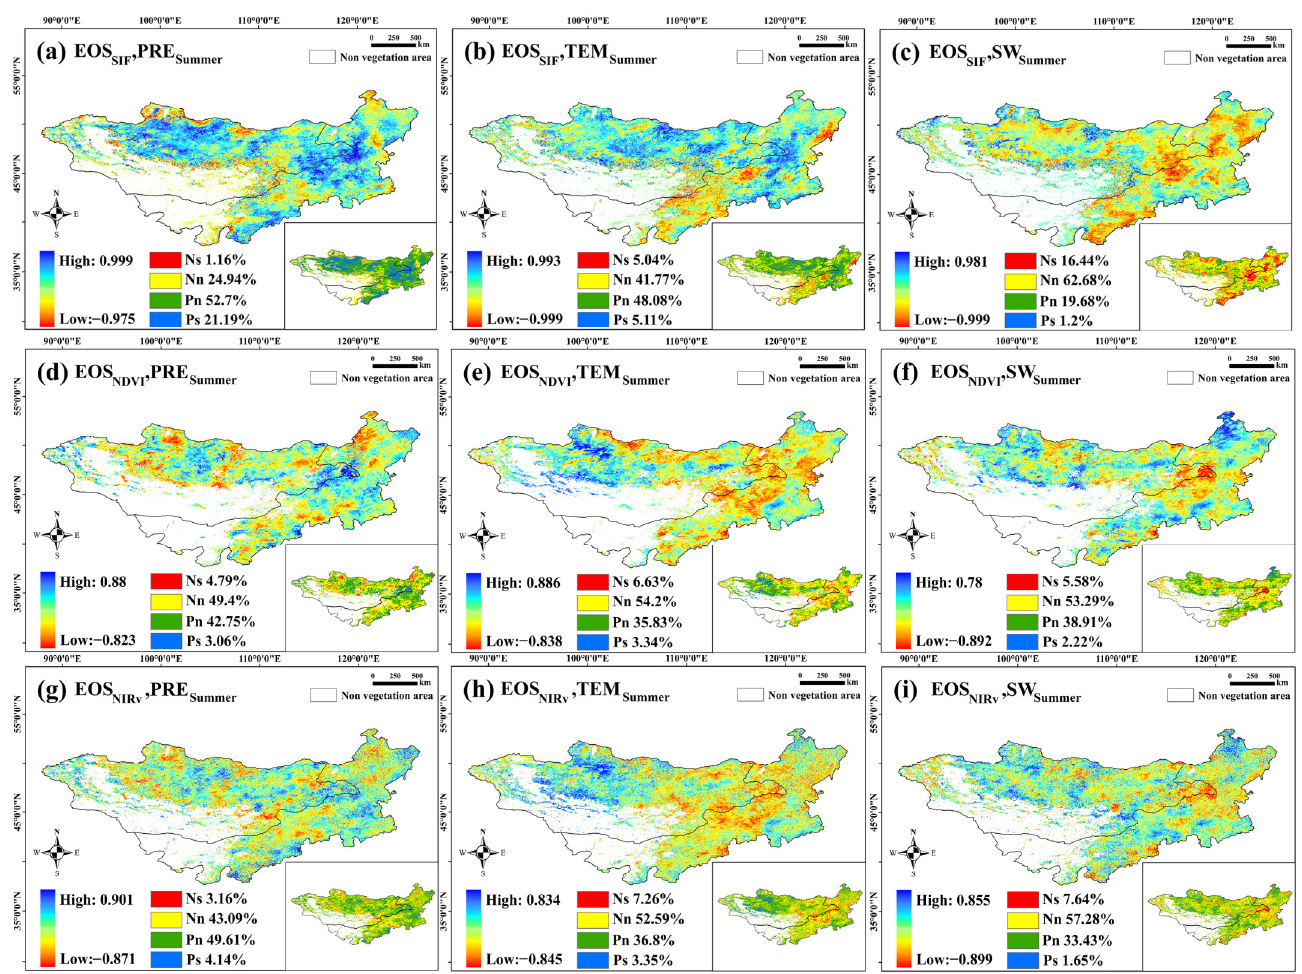
Figure 11. Spatial distributions of the correlations between temperature (TEM Summer ), precipitation (PRE Summer ), soil moisture (SW Summer ) and three types of EOS in summer.